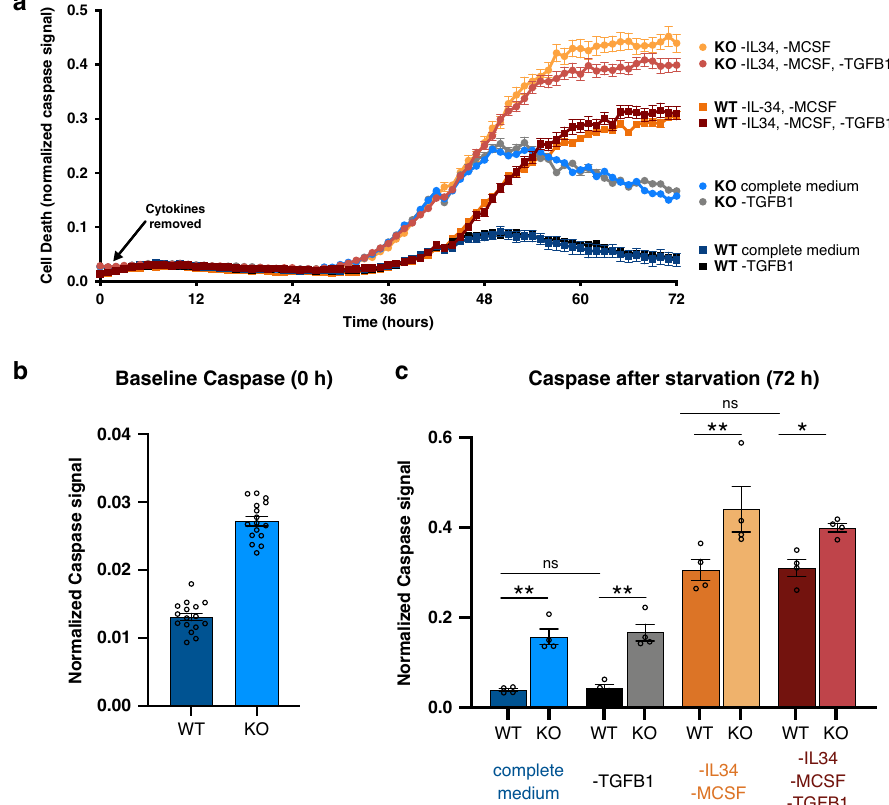
Fig. 2 TREM2 knockout microglia exhibit increased caspase activation at baseline and after cytokine starvation. a Caspase 3/7 levels imaged over 3 days in culture with complete medium (blue), no TGFB1 (gray), no IL-34, no MCSF (orange)or no IL-34, no MCSF, no TGFB1 (red). Images captured on Incucyte S3 live-cell imager. Darker shades represent TREM2 WT. Data are represented as mean values± SEM. b Quanti fi cation of caspase 3/7 after 0 h in culture. ( t -test **** p < 0.0001). Data are represented as mean values± SEM. c Quanti fi cation of caspase 3/7 after 72 h in culture. (ANOVA, Tukey post hoc test. WT vs KO complete medium: p = 0.0052, WT vs KO -TGFB1: p = 0.0035, WT vs KO -IL34/MCSF: p = 0.0014, WT vs KO -IL34/MCSF/TGFB1: p = 0.045, ns: p > 0.9999). For all panels, n = 4 images in four independent wells. Data are represented as mean values± SEM. Experiment was reproduced with two independent